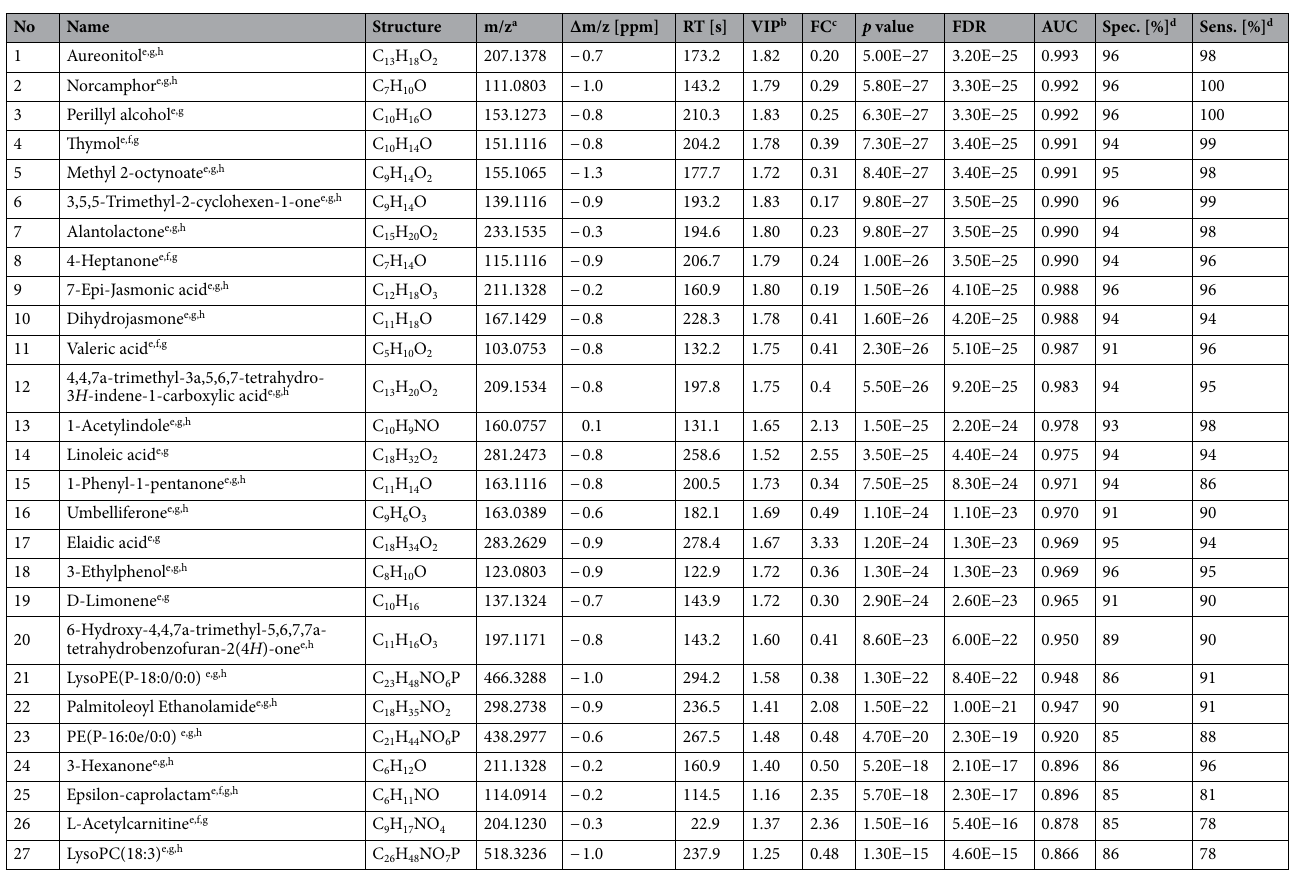
Table 1. Differential metabolites for discrimination between BC patients and NCs ( p value < 0.05; FDR < 0.05; VIP > 1; FC < 0.5 and > 2). a Experimental monoisotopic mass; b VIP scores derived from OPLS-DA model; c fold change between cancer and control serum calculated from the abundance mean values for each group— cancer-to-normal ratio; d ROC curve analysis for individual biomarkers; e the metabolites identified by high precursor mass accuracy; f the metabolites identified by matching retention time; g the metabolites identified by matching isotopic pattern; h the metabolites identified by matching MS/MS fragment spectra; AUC: area under the curve; CI: confidence interval; FC: fold change; FDR: false discovery rate; m/z : mass-to-charge ratio; RT: retention time; Sens.: Sensitivity; Spec.: Specificity; VIP: variable influence on